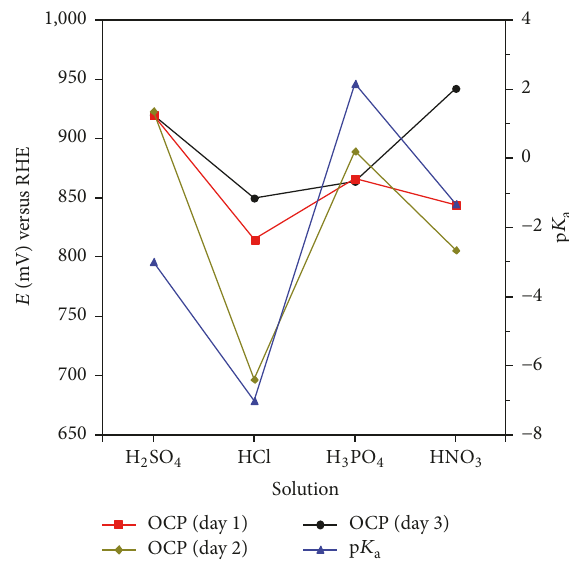
Figure 1: Fuzzy correlation of acid strength p 𝐾 a and open circuit potential of a RuO 2 electrode in different acids and